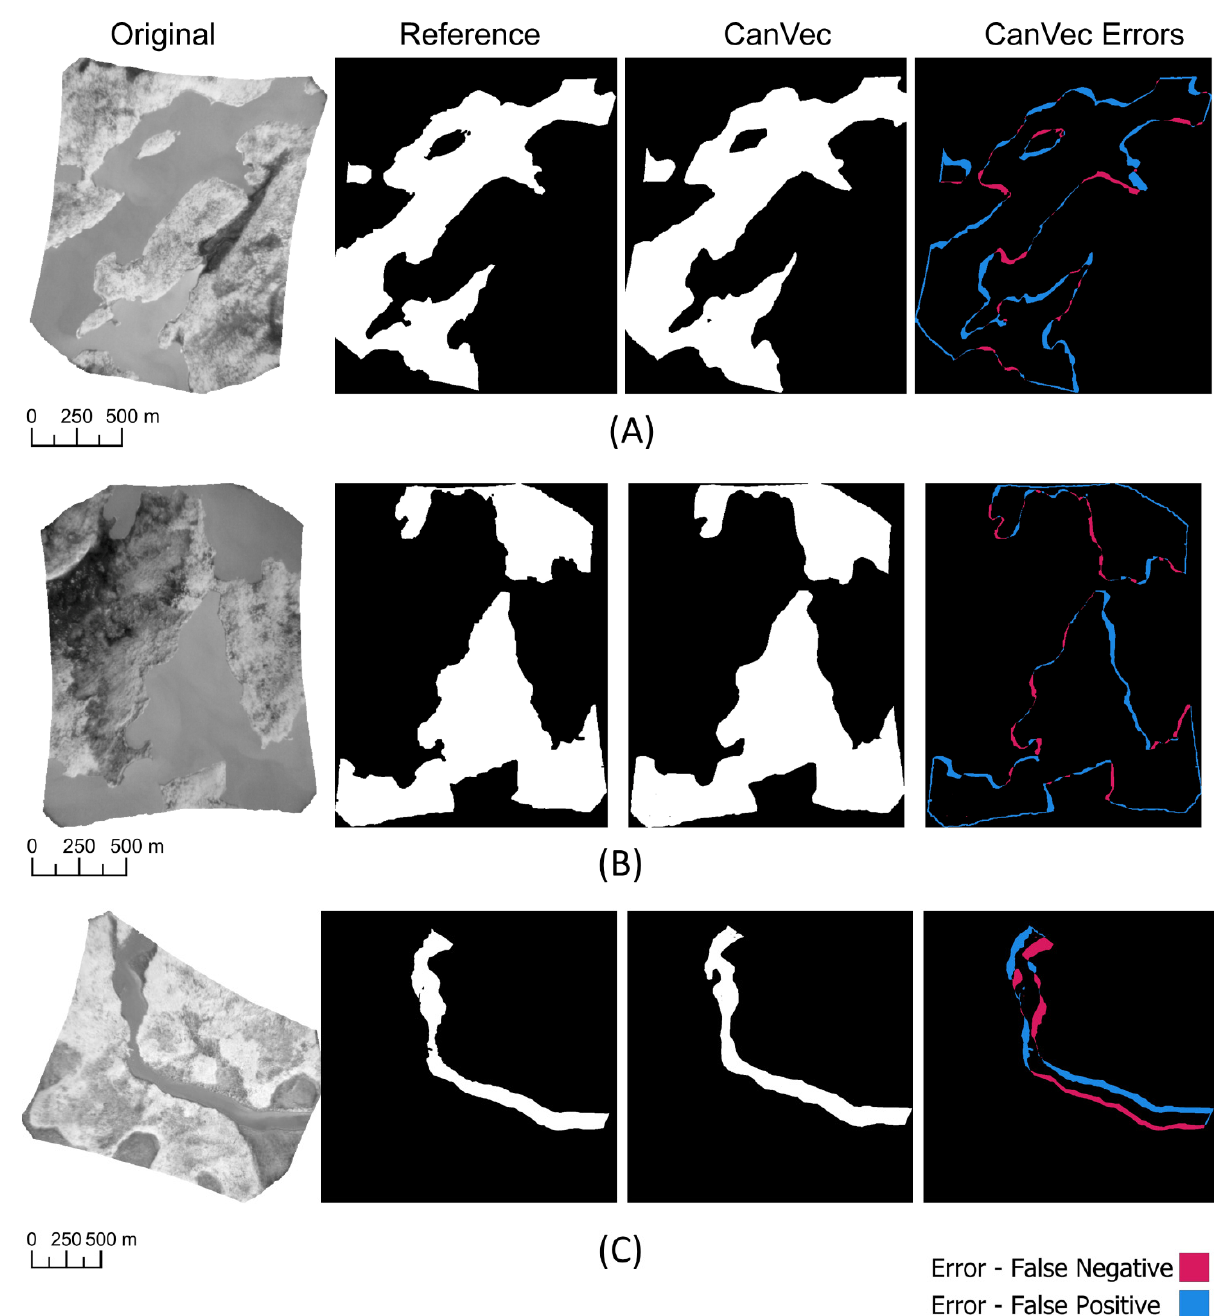
Figure 6. Typical CanVec segmentation errors. ( A) Oversimplification of waterbody edges; ( B ) Di- rectional skewing along shorelines; ( C ) Oversimplification and directional skewing errors typically intensify along narrow waterbodies.